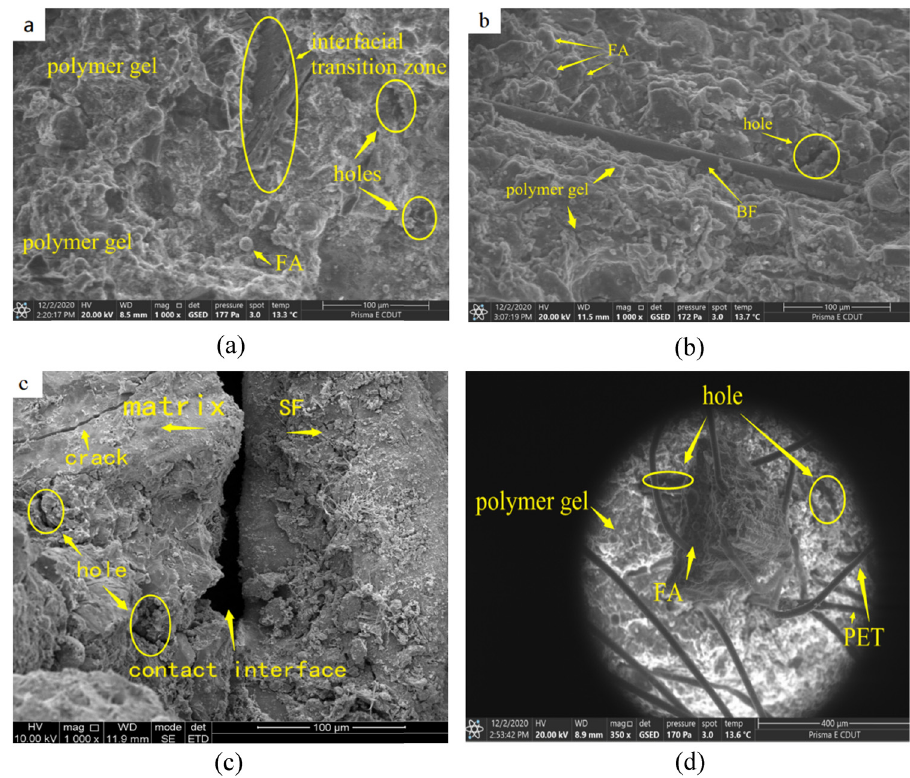
Figure 9: Micromorphology of the matrix after curing for 28 days. ( a ) CGGPC, ( b ) BFCGGPC - 0.5, ( c ) SFCGGPC - 0.5, and ( d ) PFCGGPC -